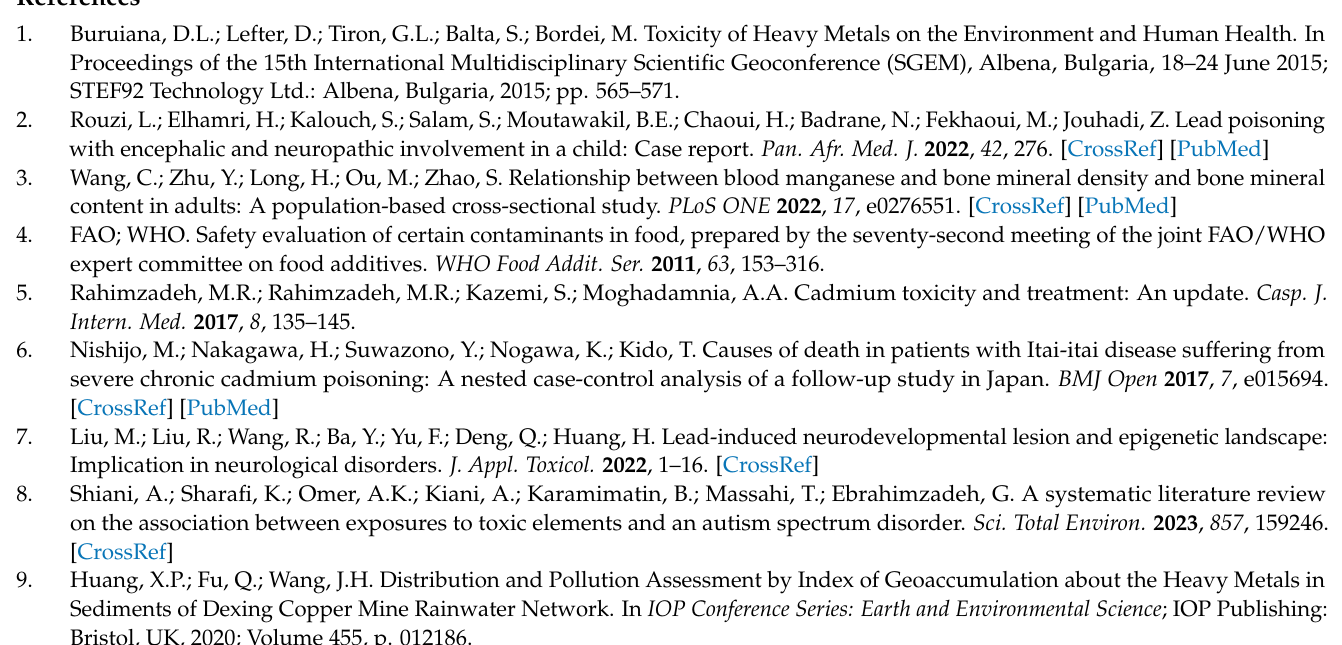
location of soil sampling sites ( n = 56); Figure S2. The recovery rates of heavy metal in the standard sample; Figure S3. Health risk assessment for soil of surrounding area and non-ferrous metal smelting plant (NMSP): (a) cancer risk and (b) non-cancer risk; Table S1. Microwave digestion reference procedure; Table S2. Classification of geoaccumulation index (I geo ) and Enrichment factor (EF); Table S3. Parameter meaning and selected value of the average daily intake of heavy metals in soil; Table S4. Parameters for non-cancer risk and cancer risk assessment; Table S5. The concentrations of heavy metals in the control area (mg/kg); Table S6. Summary of the risk screening standards levels (mg/kg) for heavy metals under investigation; Table S7. The median concentrations of heavy metals in investigations of other countries; Table S8. The exposure level of the adults and children in the surrounding area and non-ferrous metal smelting plant (NMSP) for non-cancer risks assessment; Table S9. The exposure level of the adults and children in the surrounding area and non-ferrous metal smelting plant (NMSP) for cancer risks assessment. References [25,34,37,38,45,62–69] are cited in the Supplementary